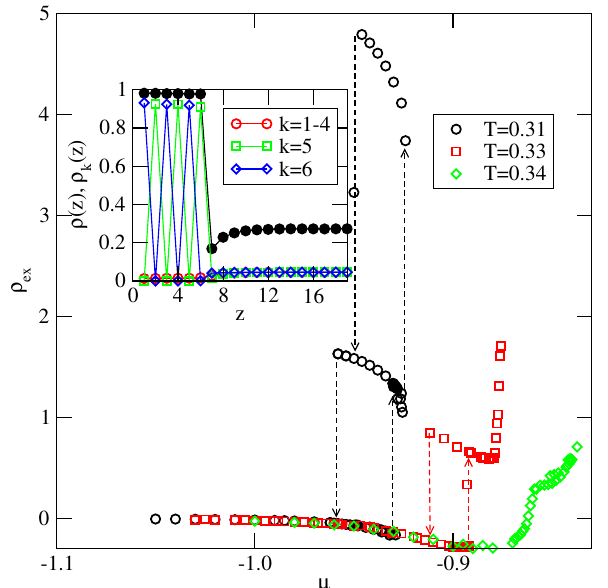
Figure 14. The adsorption isotherms for the system with u ∗ = 0.0 and V o = − 0.01 at the temperatures given in the figure. The inset shows the profiles ρ ( z ) , ρ k ( z ) , recorded at T = 0.31 and µ = − 0.93. At the temperatures equal to 0.33 and 0.34, the adsorbed films also become quite thick when the chemical potential approaches bulk coexistence, though the surface excess densities are rather low, since the dilute phase attains high density. Figure 15 shows the local density profiles recorded at T = 0.33 and 0.34, for the chemical potentials close to